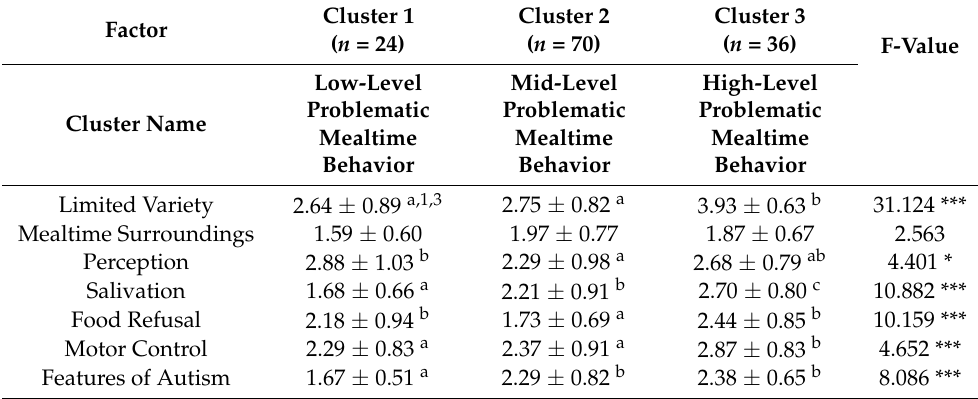
Table 5. Cluster analysis of ASD students’ mealtime behavior through factor analysis 2